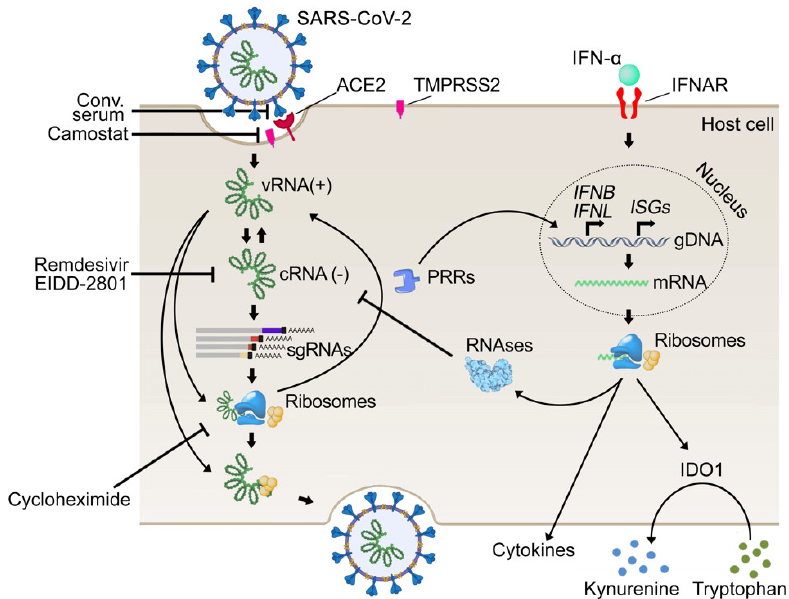
Figure 7. Schematic representation of mechanisms of anti-SARS-CoV-2 actions of remdesivir, EIDD-2801, camostat, cycloheximide, and convalescent serum, and stages of virus replication cycle they target.